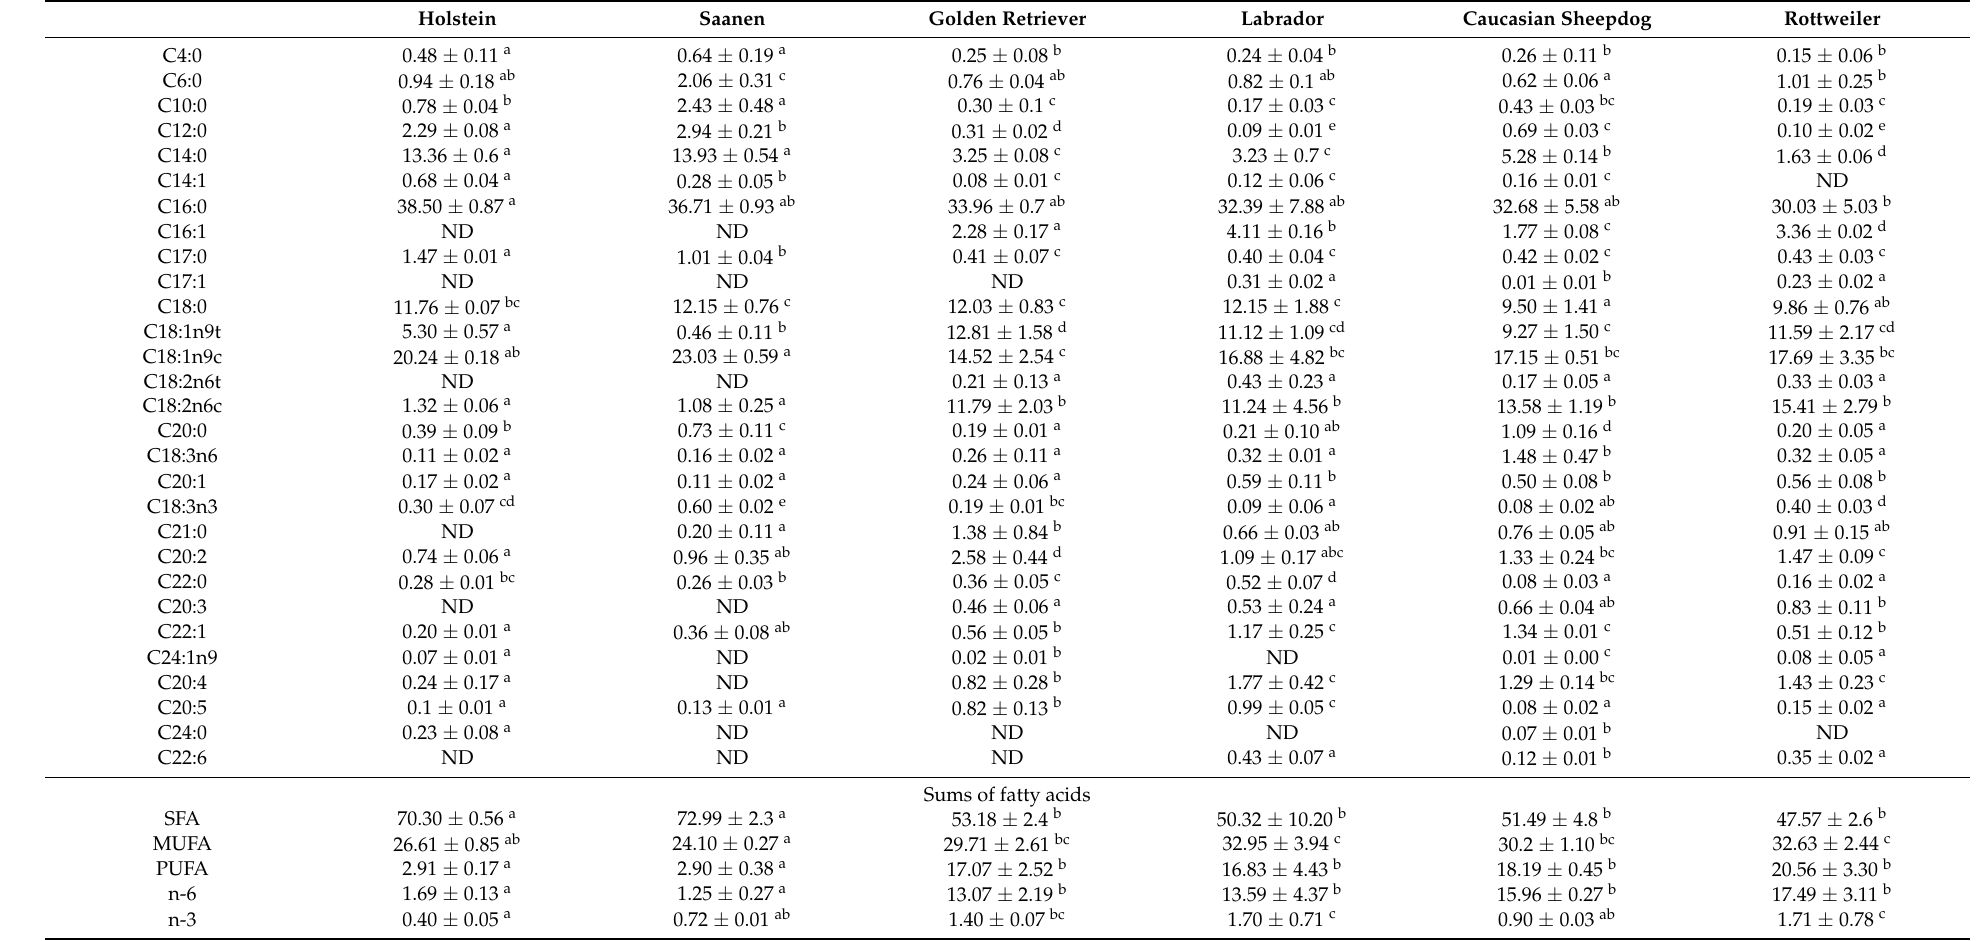
Table 3. Fatty acid profiles of canine, bovine, and caprine milk (g/100 g total fatty acid). Holstein Saanen Golden Retriever Labrador Caucasian